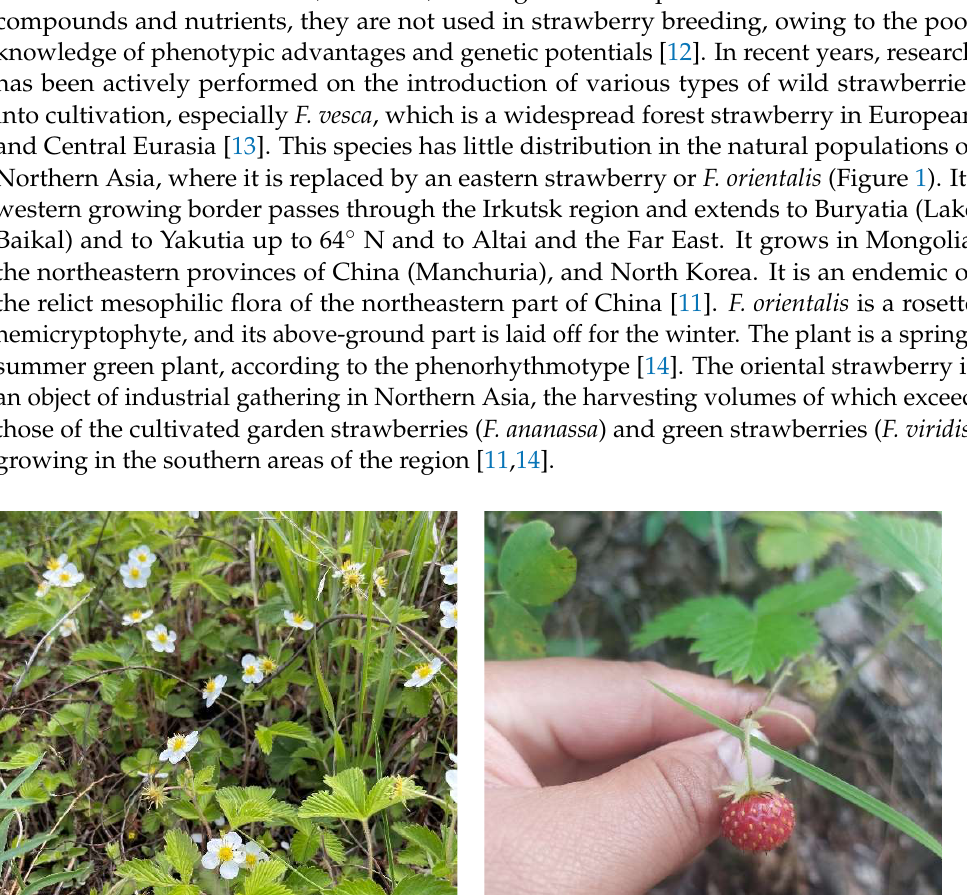
wild berries, but slightly inferior. The shape of the berries varies from cylindrical, ovoid, or heart-shaped to round. The cavity in the berries is absent or insignificant. The pulp